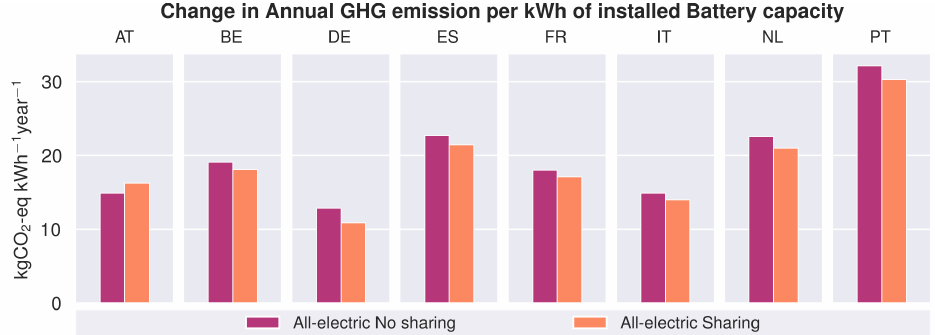
Figure 9. Greenhouse gas emission reduction potentials for BESS in the eight selected countries. Data are shown as the change in annual emissions related to due to charging and discharging of the BESS, including upstream emissions related to manufacturing of the BESS. Note that positive bars imply an increase in